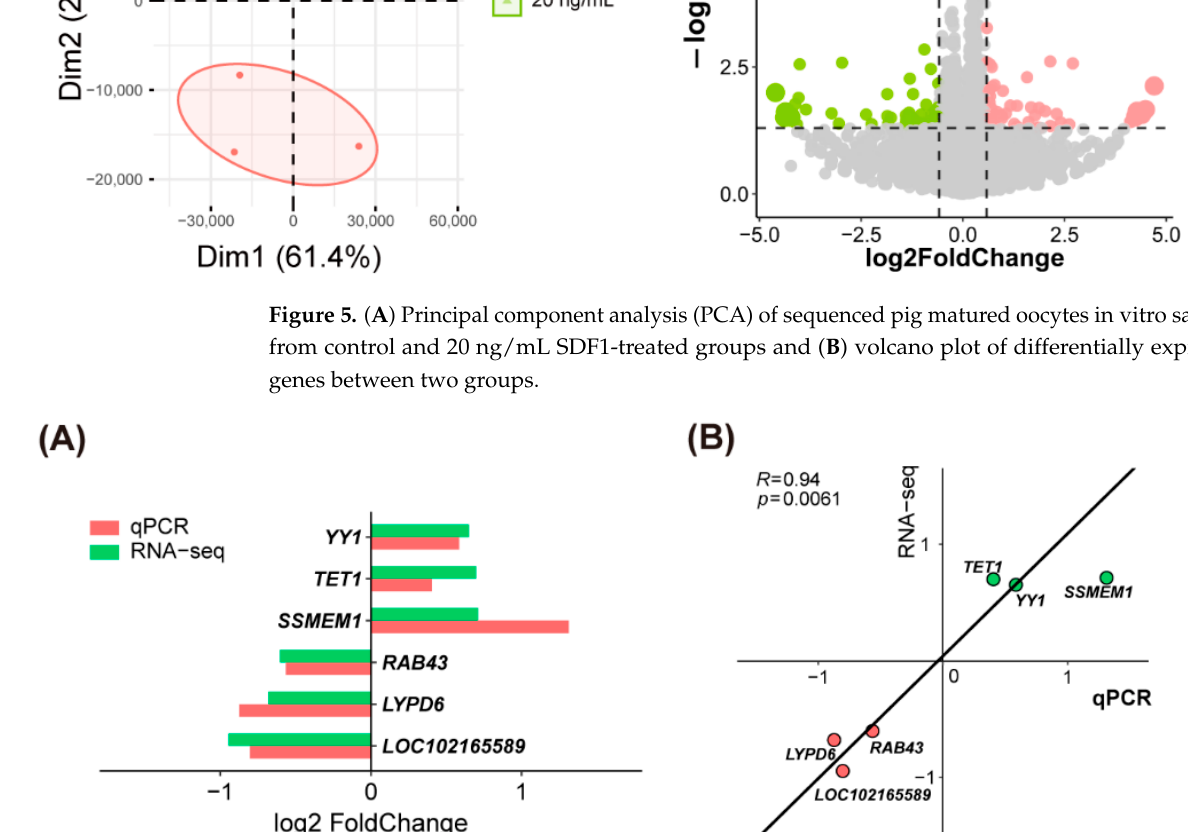
SDF1 treatment groups.